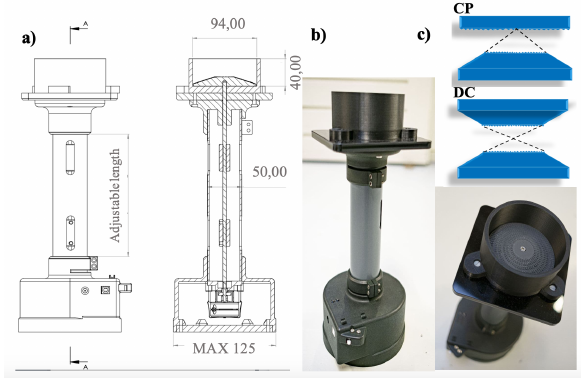
Figure 1. (a) Schematic of the new shearing setup. The 2D sketches indicate the dimensions (in mm) in detail, (b) Actual images of the setup, part of which was constructed with 3D print- ing techniques, and (c) CP (Cone / Plate) and DC (Double Cone)